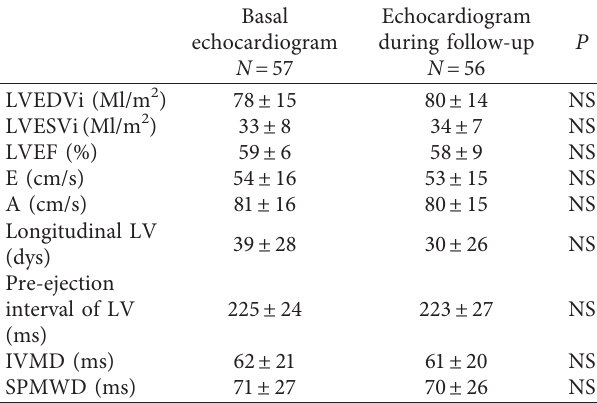
Table 2: Echocardiographic parameters on enrollment and during follow-up. Data during follow-up do not include those of the patient who developed a dilated cardiomyopathy. n . (%)